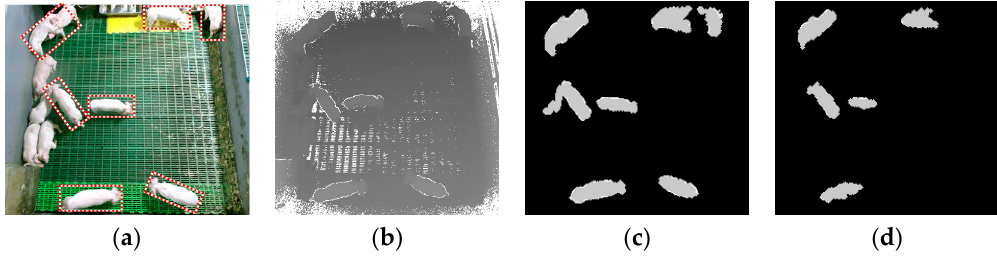
Figure 12. Differences of detecting standing-pigs according to threshold1 : ( a ) color image; ( b ) depth image; ( c ) detection of standing-pigs with threshold1 = 9; and ( d ) detection of standing-pigs with threshold1 = 15.